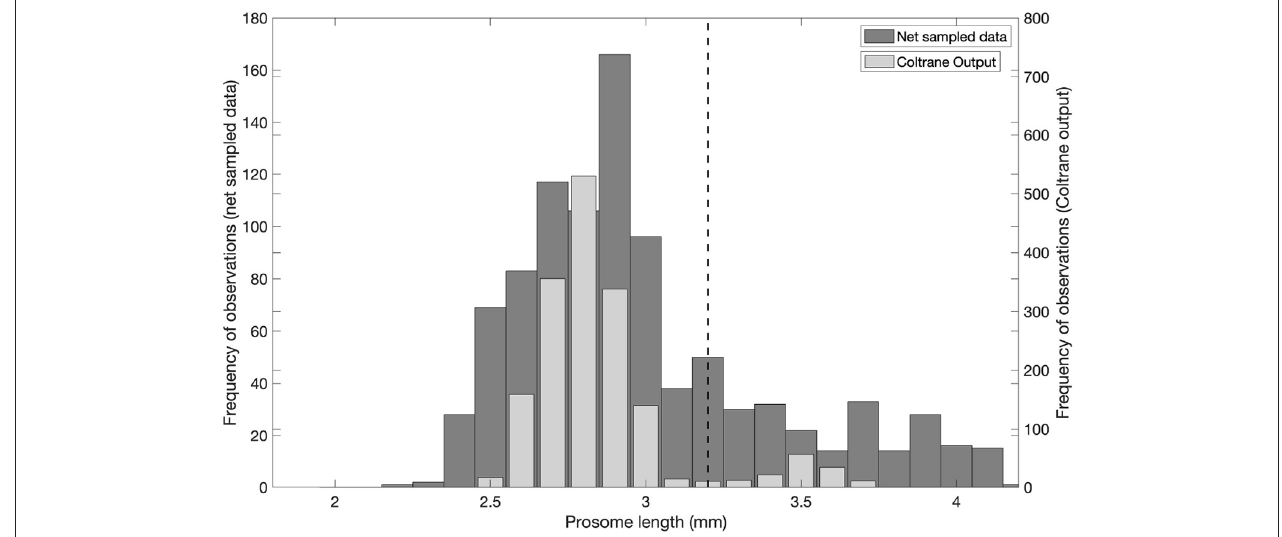
FIGURE 4 | Comparison of predicted body size from the Coltrane model [converted from weight following Runge et al. (2006)] with net sampled Calanus from Svalbard. Dashed line at prosome length = 3.2 mm indicates separation between C. finmarchicus and C. glacialis adult females as per Kwasniewski et al. (2003).